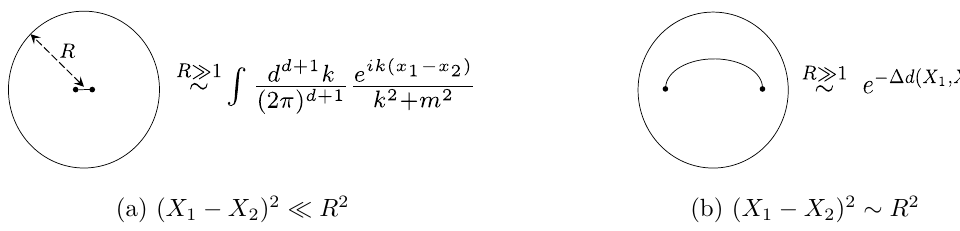
Figure 2. Two different limits of the bulk-bulk propagator. ( a ) If the two bulk points are close to each other ( X 1 − X 2 ) 2 (cid:28) R 2 , the large R limit gives a propagator in flat space. ( b ) If the two bulk points are kept apart, the limit is described by a geodesic in AdS which connects the two points. In this case, the propagator falls off exponentially e − ∆ d ( X 1 ,X 2 ) where d ( X 1 , X 2 ) is a geodesic distance between the two